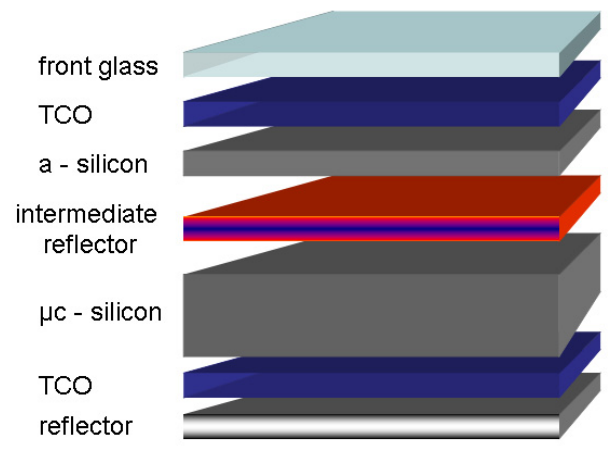
Figure 14. Schematic sketch of the micromorph tandem cell concept. The top cell is deposited directly on a textured zinc oxide front glass (front glass + TCO). The texturing introduces a roughness which is essential for light trapping in the thin solar amorphous silicon solar cell. Between the two solar cells, the intermediate reflector is placed, increasing the number of photons absorbed by the top cell. The bottom cell is followed by another TCO contact and a metallic back reflector. The bottom cell’s thickness is ca. 2 µm, while the top cell’s thickness is limited to 0.15 − 0.3